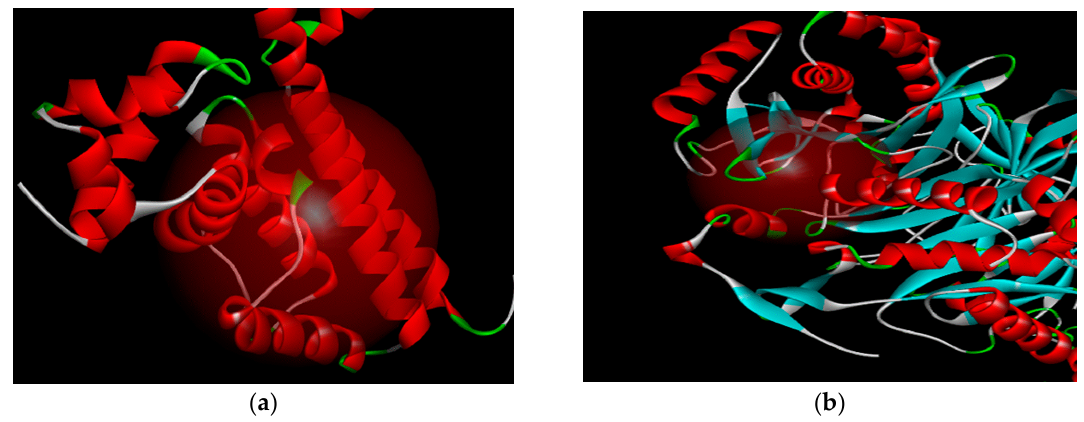
Figure 9. The red globular region in the figure shows the location of the target protein active site. ( a ) Active site of target protein 2XRL (target protein receptor of doxycycline) and ( b ) active site of target protein 1Q23 (target protein receptor of Fusidic acid).